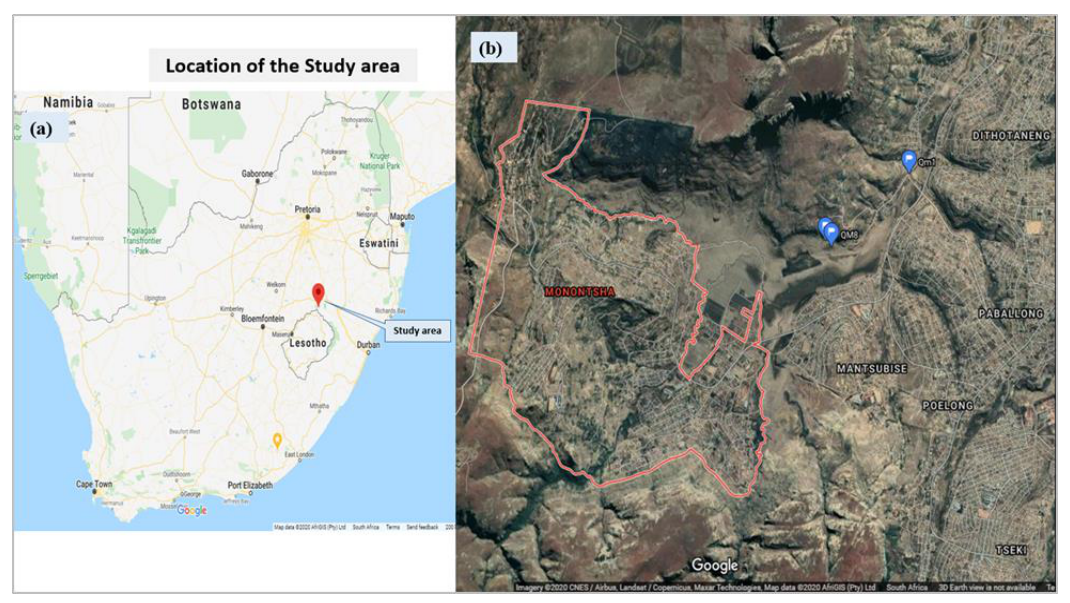
Figure 1. ( a ) and ( b ). Map showing the study location.